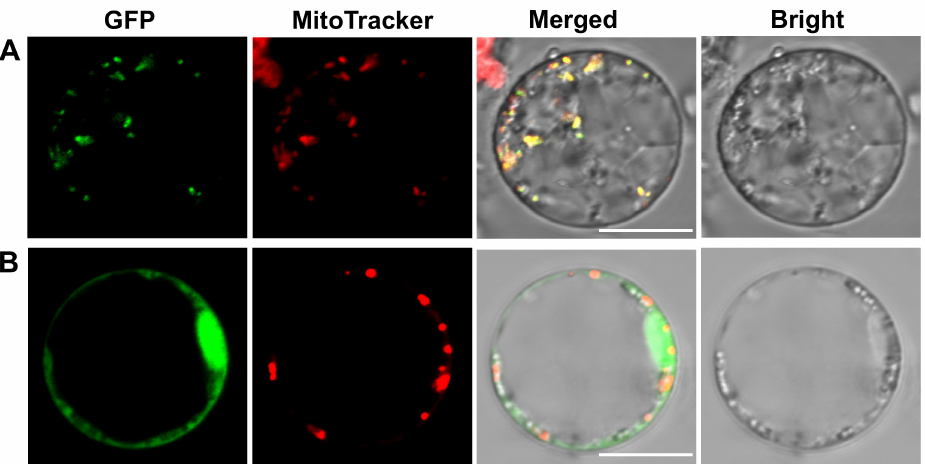
Figure 10. Subcellular localization of OsSDH2-1 protein. ( A ) OsSDH2-1-GFP (Green fluorescent protein) fusion protein. ( B ) Empty GFP. Green fluorescence indicates the signals from GFP protein, and red fluorescence shows the signals from mitochondria stained with MitoTracker Red CMXRos. Bars = 5 µ